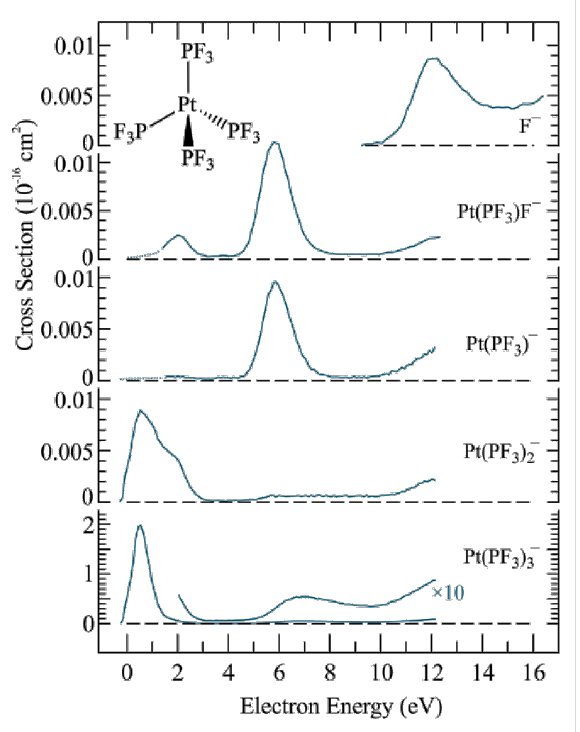
Figure 12: Energy-dependent absolute cross sections for negative ion fragments produced by DEA to Pt(PF 3 ) 4 (reproduced with permission from May et al. [14], Copyright (2012) Royal Society of